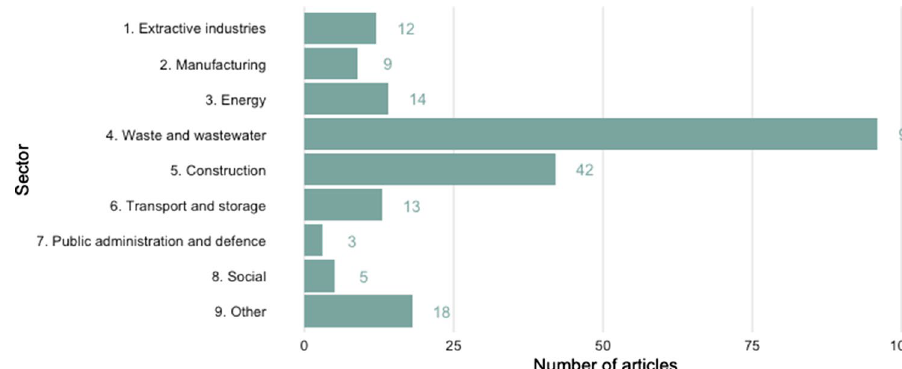
Fig. 5 Sectors examined across the included